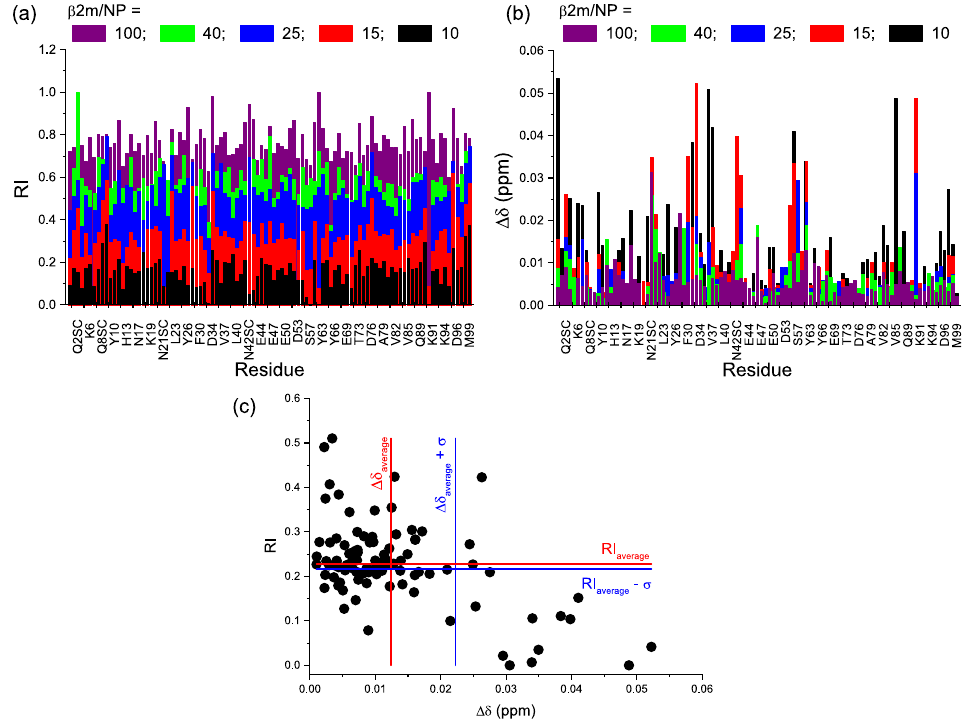
Figure 5. ( a , b ) Bar plots of amide resonance chemical shift perturbations ( Δδ ) and cross ‐ peak attenuations (RI), respectively. Refer to color legend for the protein/NP ratios; ( c ) Scatter plot indicating the correlation between chemical shift deviation ( Δδ ) and relative intensity (RI) attenuation, each point corresponds to an amide resonance. Tick marks and labels are reported every 3 residues, except for the missing and undetected ones, i.e., I1, P5, P14, G29, P32, L54, K58, D59, W60, F62, P72, S88, and P90. The observed side chain (SC) NHs are also included, i.e., two for Q2, two for Q8, one for N17, two for N21, two for N24, two for Q89, and one for W95. The variation of the resonance position accounts for a change in the chemical environment around a specific amide group and the accompanying signal intensity decrease reflects the line broadening, i.e., transverse relaxation rate increase, from additional exchange and possibly cross ‐ relaxation contributions. These two features are both related to the exchange process between free and NP ‐ contacting states. The occurrence of single resonances whose position reflects the population ‐ weighted chemical shift average of the free and the NP ‐ close forms of the protein implies that the exchange regime is not slow, nor intermediate with respect to the NMR chemical shift scale. The observed pattern is consistent with a nearly fast exchange regime with residual line ‐ broadening contributions that, besides the dissociation rate from the NP adduct, may also reflect more or less transient changes in the local dynamics and the overall rotational tumbling rate that affect both